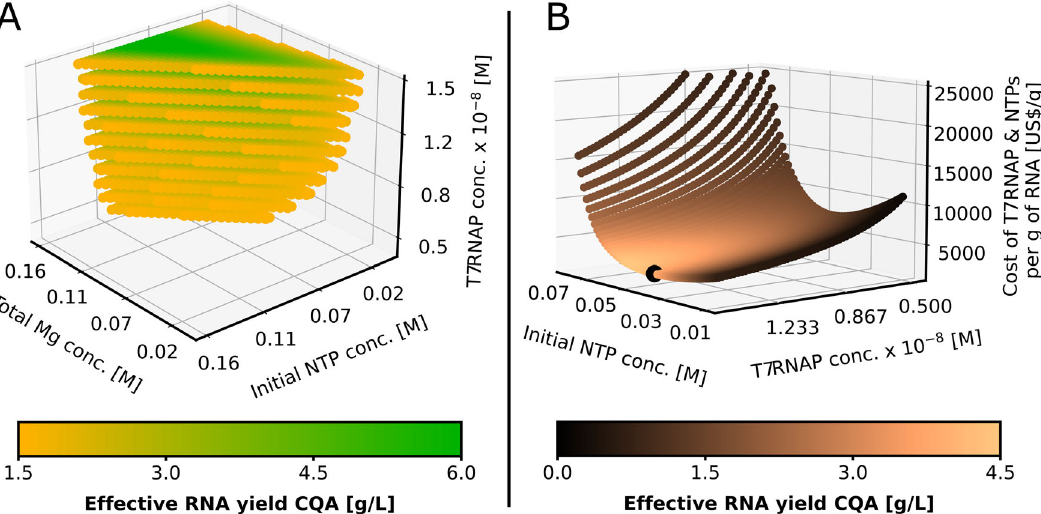
Fig. 3 Deterministic design space (DS) and cost per yield surface. A Three-dimensional deterministic DS mapping the relationship between CPPs initial total solution Mg, NTP and T7RNAP concentration with the effective RNA yield CQA. Every point within the DS meets the 1.5 g/L RNA production target and the greener the region, the higher the yield. B Yield-cost-concentration plot showing RNA production yield and T7RNAP and NTP cost per g of RNA in the function of T7RNAP and NTP concentrations at 85 mM constant Mg concentration. The black sphere marks the cost